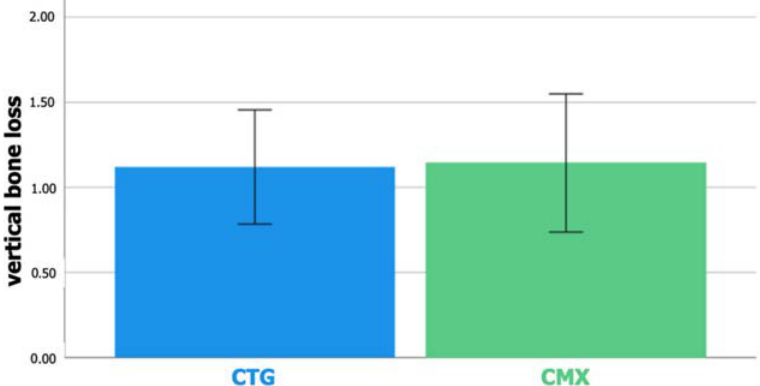
Figure 5. Bar chart representing mean vertical buccal bone loss. Error bars: 95% confidence interval.